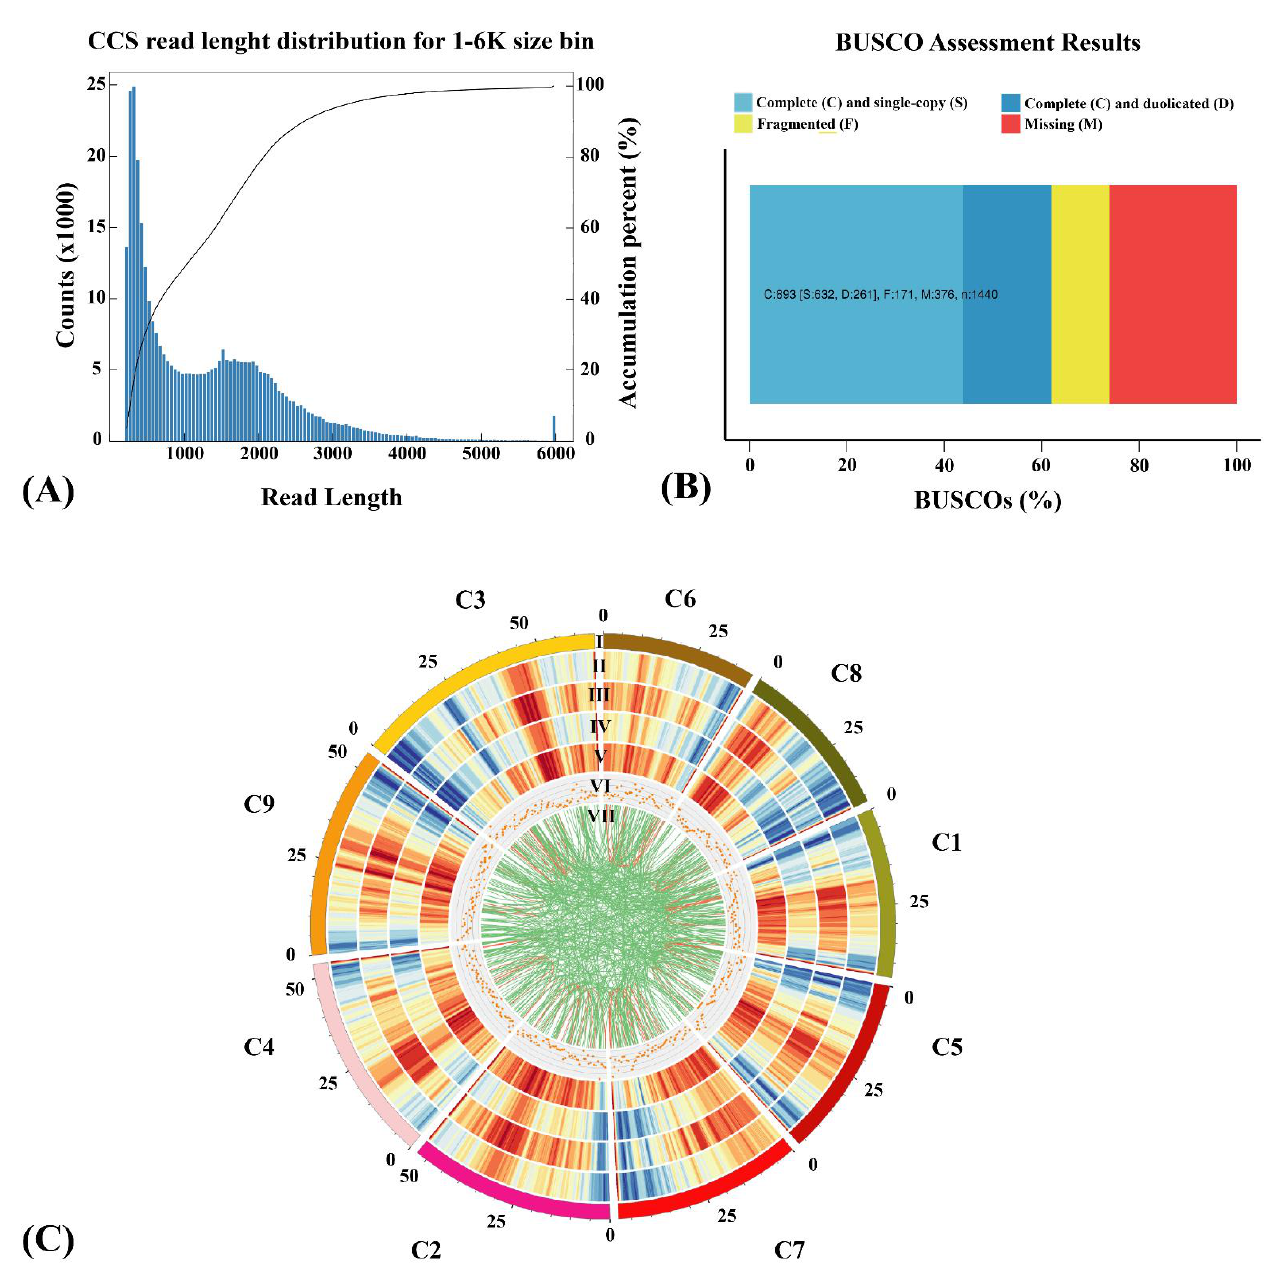
Figure 3. Full-length transcriptome quality assessment. ( A ) Distribution of CCS length. ( B ) BUSCO integrity assessment of full-length transcriptome data. ( C ) Circos visualization at the genome level. (I) Chromosome. (II) Gene density in the genome. (III) Gene density in PacBio SMRT-seq. (IV) Tran- script density in the genome. (V) Transcript density in PacBio SMRT-seq. (VI) Distribution density of LncRNA on the chromosome. (VII) Distribution of the fusion